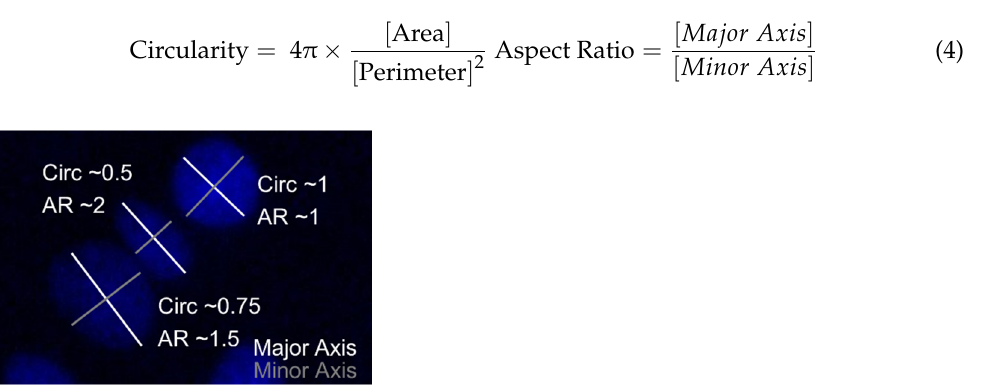
Figure 2 . Visualization of nuclear shape on DAPI stained nuclei. If the ratio of the major nuclear axis to the minor nuclear axis, Table 1, a more elongated shape is seen. Circularity (Circ.) is meas- axis to the minor nuclear axis, the aspect ratio (AR), is bigger than 1, a more elongated shape is seen. ured between 0 and 1, the value being close to 1 represents a rounder cell shape. Circularity (Circ.) is measured between 0 and 1, the value being close to 1 represents a rounder cell